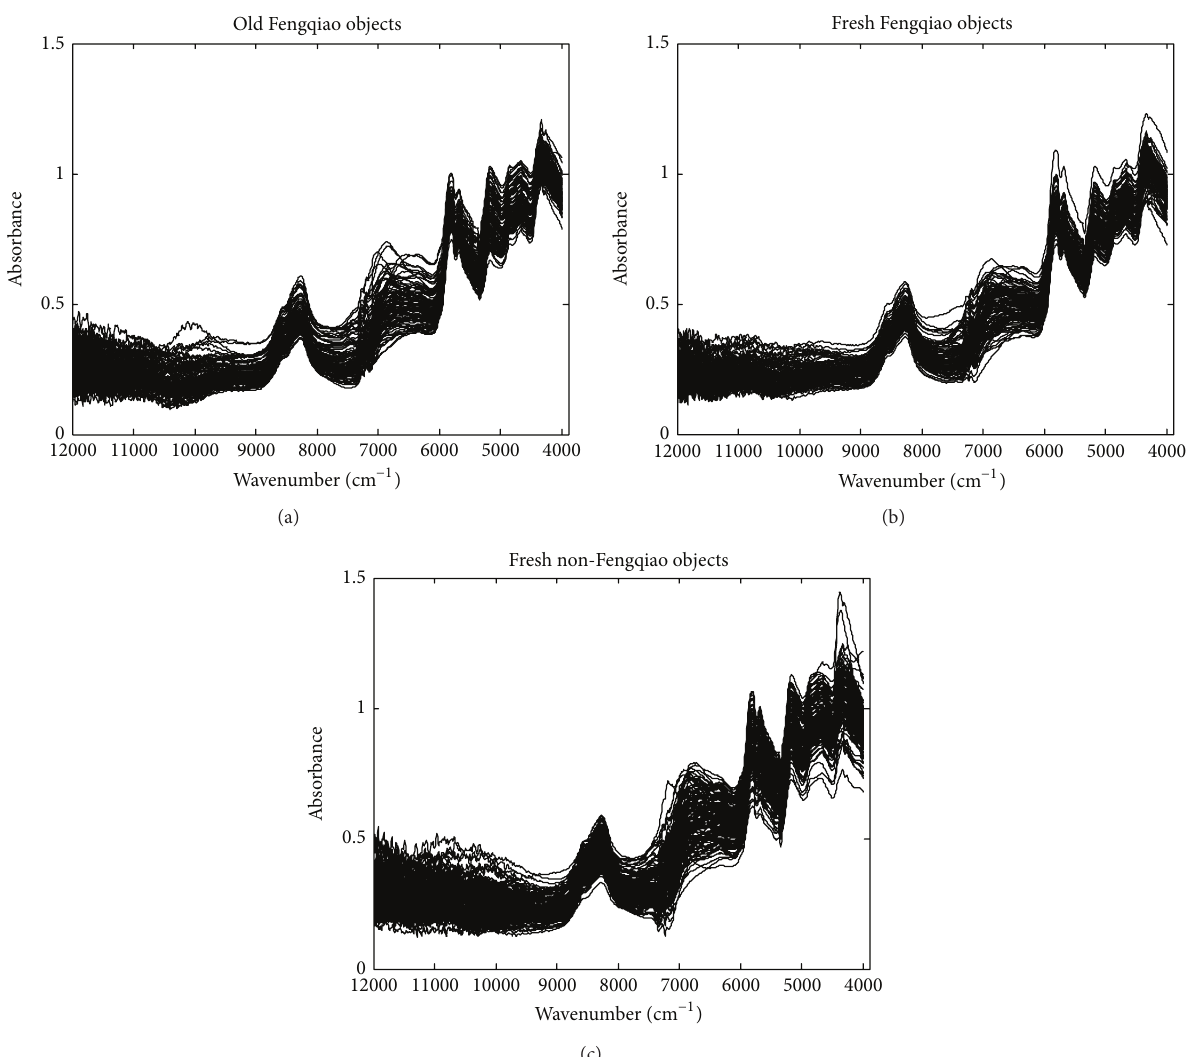
Figure 1: Raw NIR spectra of T. grandis seed kernels from Fengqiao (old, 𝑛 = 97 ), Fengqiao (fresh, 𝑛 = 110 ), and other areas (fresh, 𝑛 = 130 ).